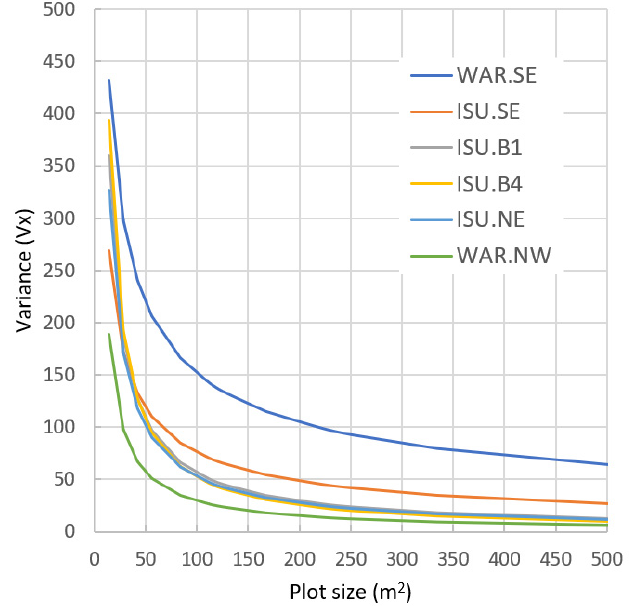
Figure 2. Estimated variance per unit area among plots of various sizes and shapes from six maize uniformity trials based on predicted values calculated from regression of log (variance) on log (length). While the general shape of the curves was similar among all six sites, the degree of soil heterogeneity differed. The interpolated yield maps in Figure 3 illustrate the presence and degree of soil heterogeneity within each site.